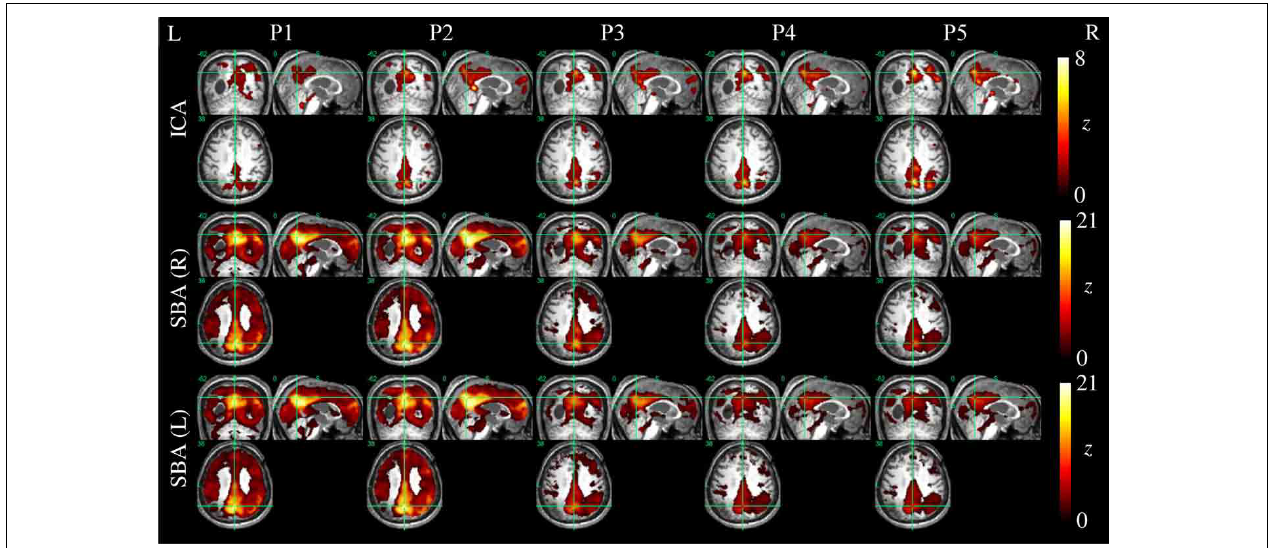
FIGURE 6 | DMN functional connectivity maps computed with ICA (top row) and SBA (middle and bottom rows) for a patient with a clinical diagnosis of vegetative state (maximum displacement 4.0mm, 27/200 outlier volumes). As preprocessing steps were added (left to right, P1–P5),